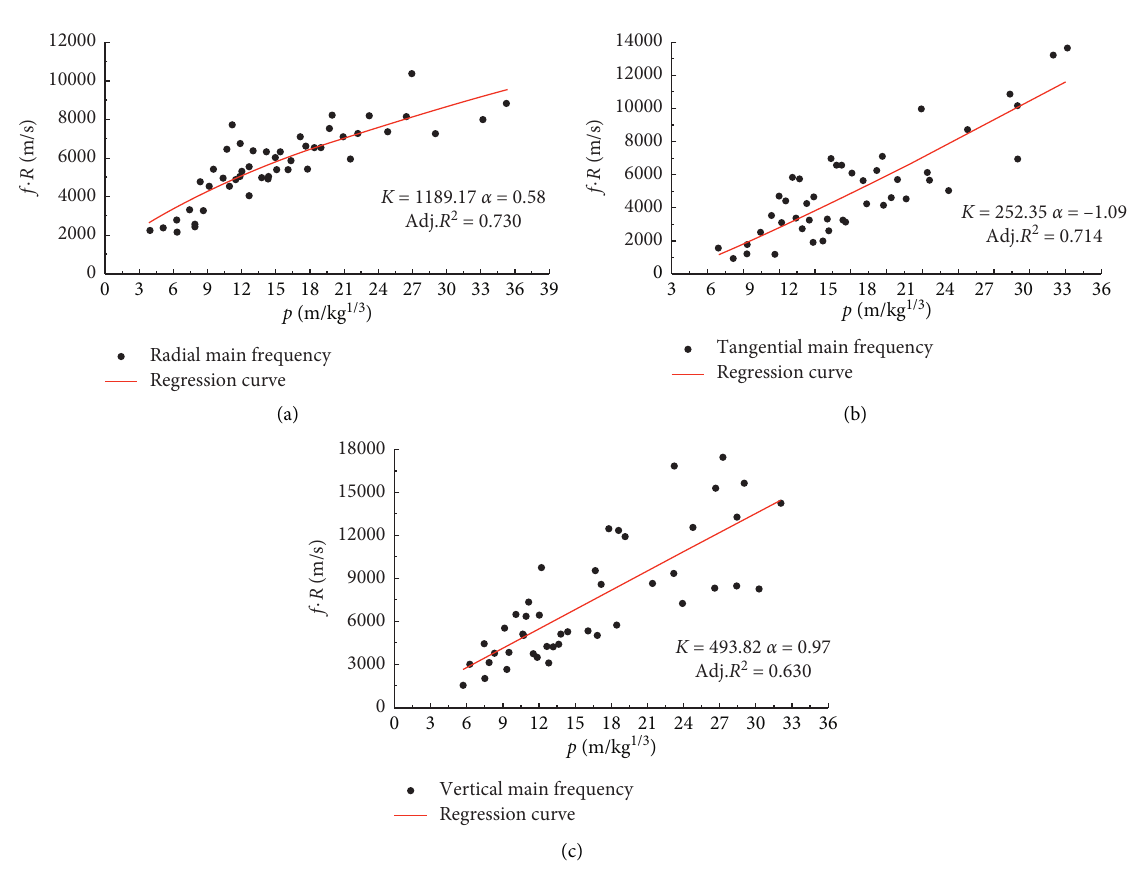
Figure 9: The regression curve of (a) radial main frequency, (b) tangential main frequency, and (c) vertical main